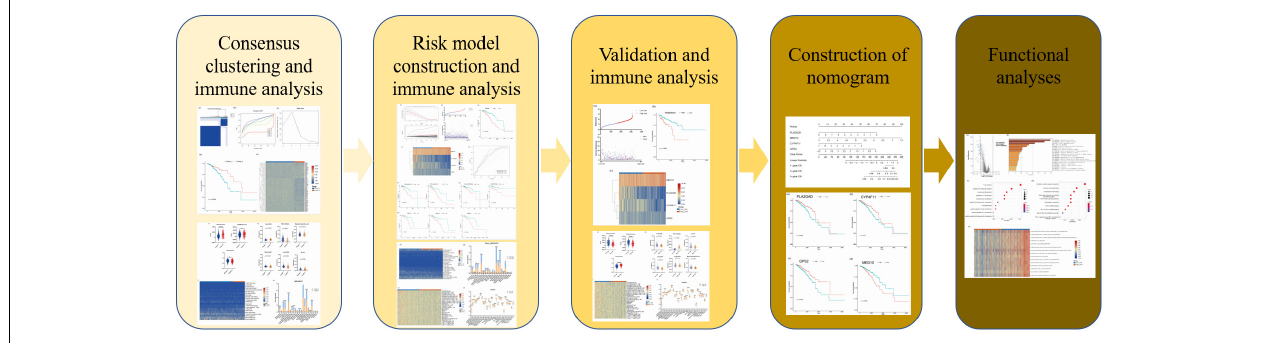
FIGURE 1 | The scheme diagram of data